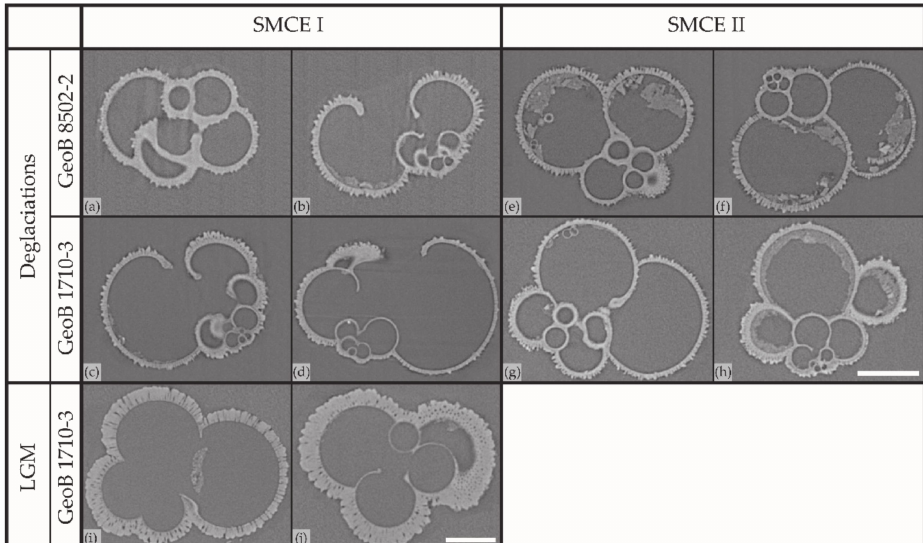
Figure 4. X-ray tomographs of G. bulloides specimens of cores GeoB 8502-2 and GeoB 1710-3; ( a–d ) specimens from shell mass convergence event SMCE I; ( e–h ) specimens from SMCE II; and ( i–j ) Last Glacial Maximum specimens from core GeoB